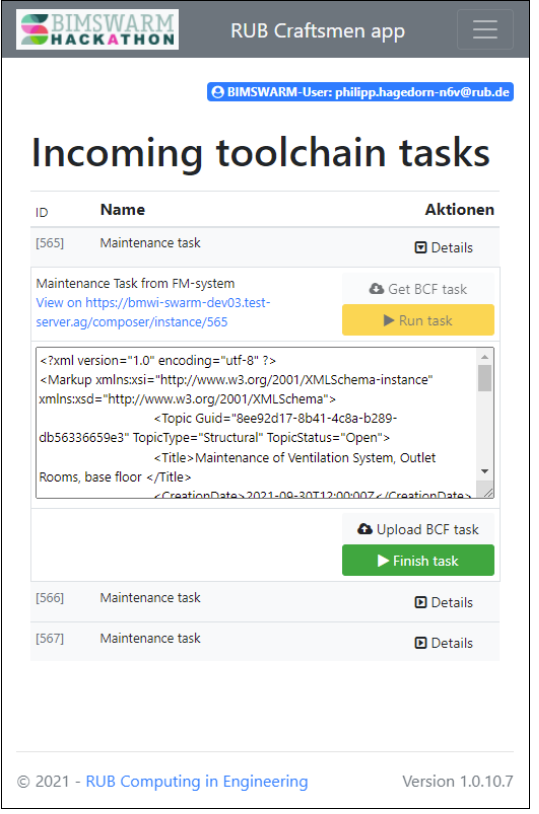
Figure 11. Evaluation of the use case in a client app RUB Toolchain client provided at GitHub